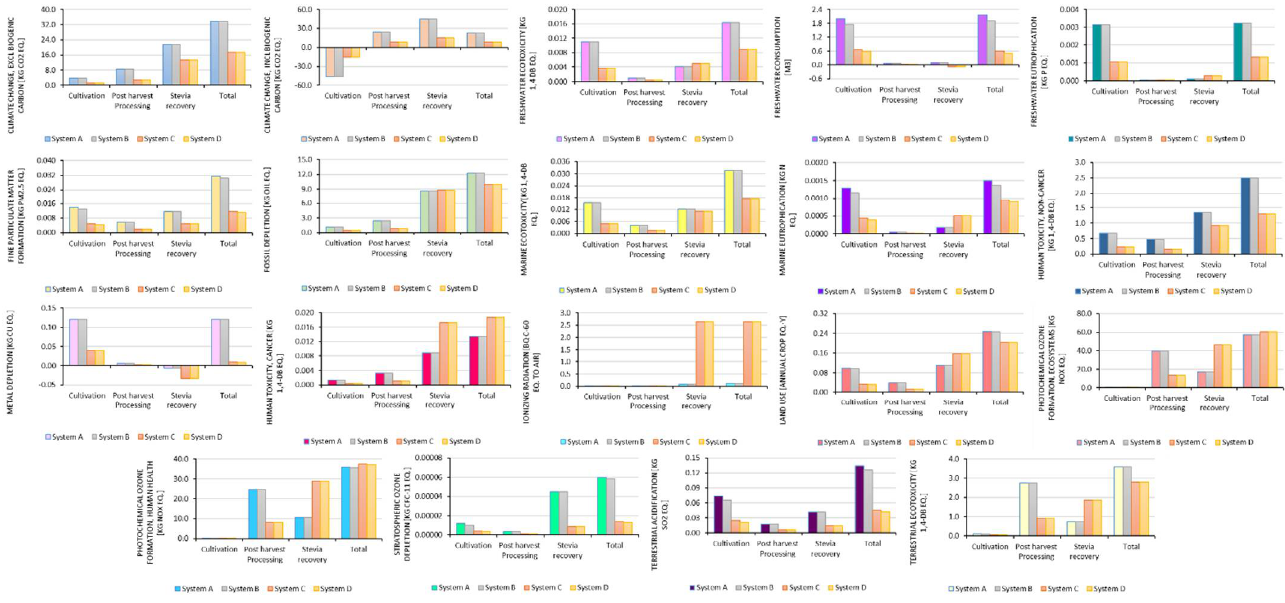
Figure 4. Comparison of the impact categories for the different systems.